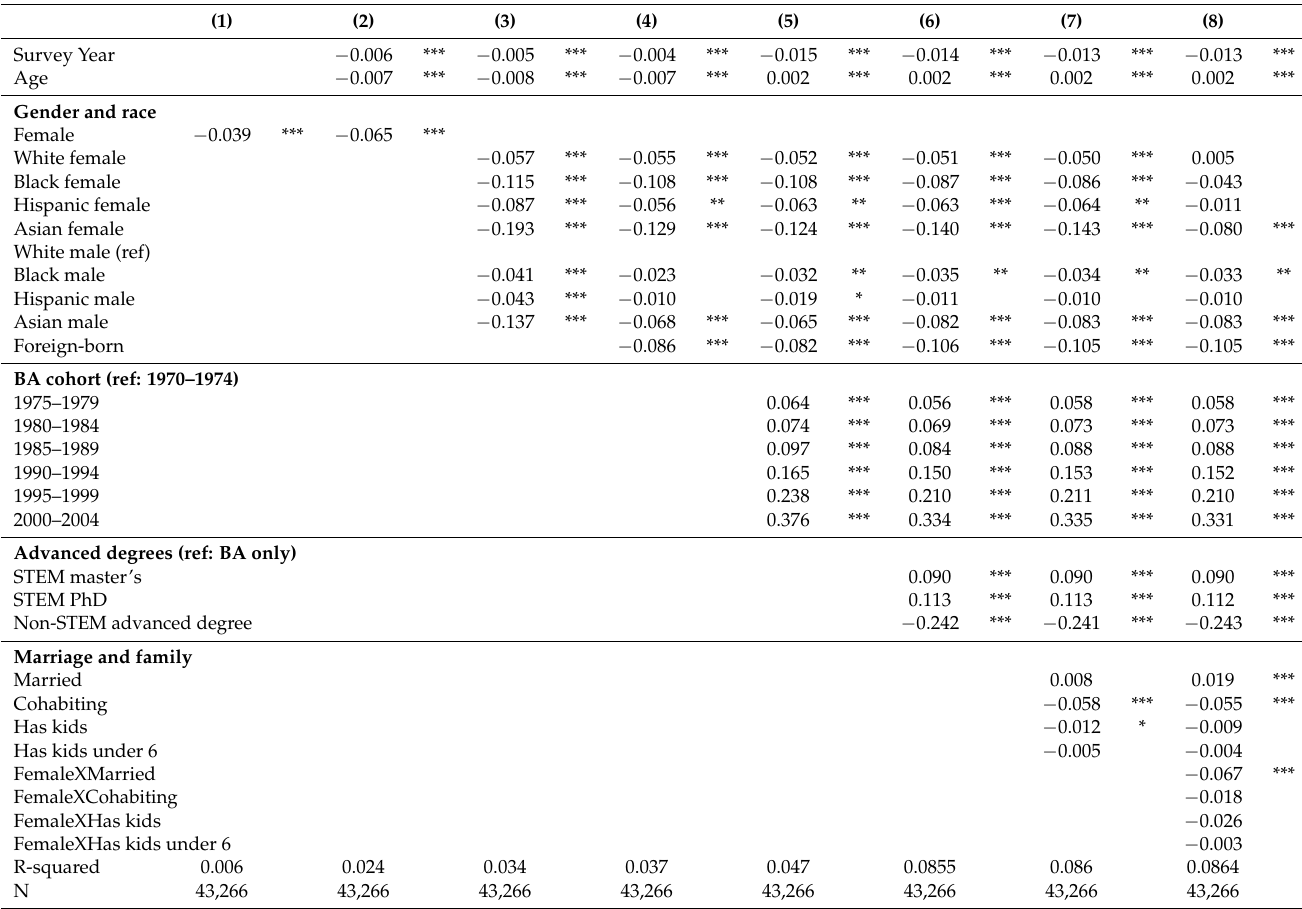
Table A3. Linear probability models predicting working in an engineering occupation: Engineering degree